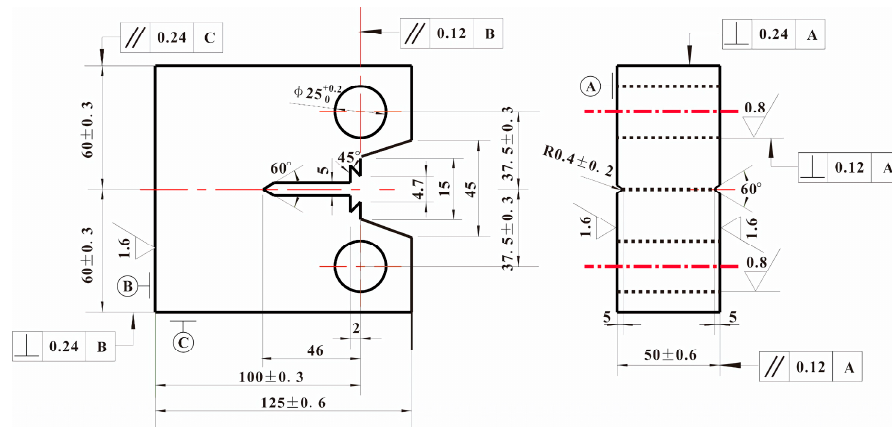
Figure 2. Size of C(T) specimen in fracture toughness test.